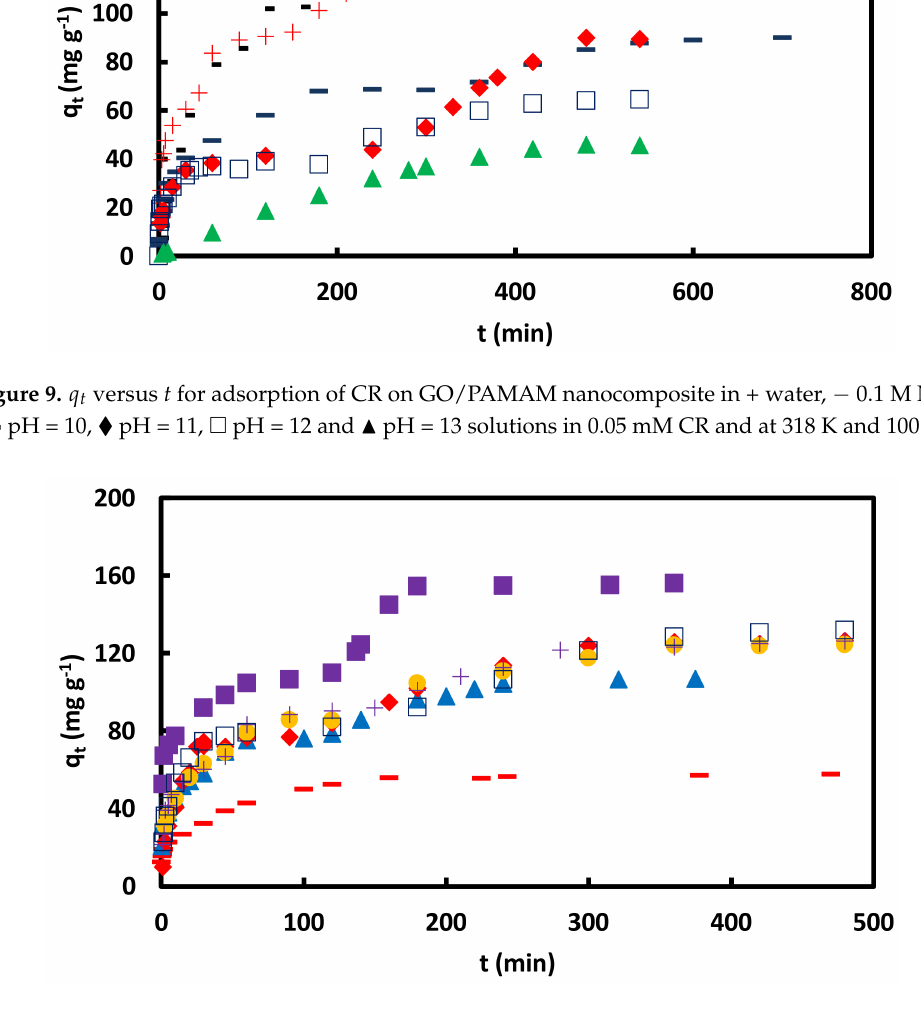
Figure 10. q t versus t for adsorption of CR on GO/PAMAM nanocomposite in 0.02, (cid:78) 0.05 and (cid:4) 0.09 mM CR at 308 K and 100 rpm; in 0.05 mM CR at (cid:7) 40, 70 and +100 rpm at 318 K and (cid:3) 0.05 mM CR at 328 K and 100